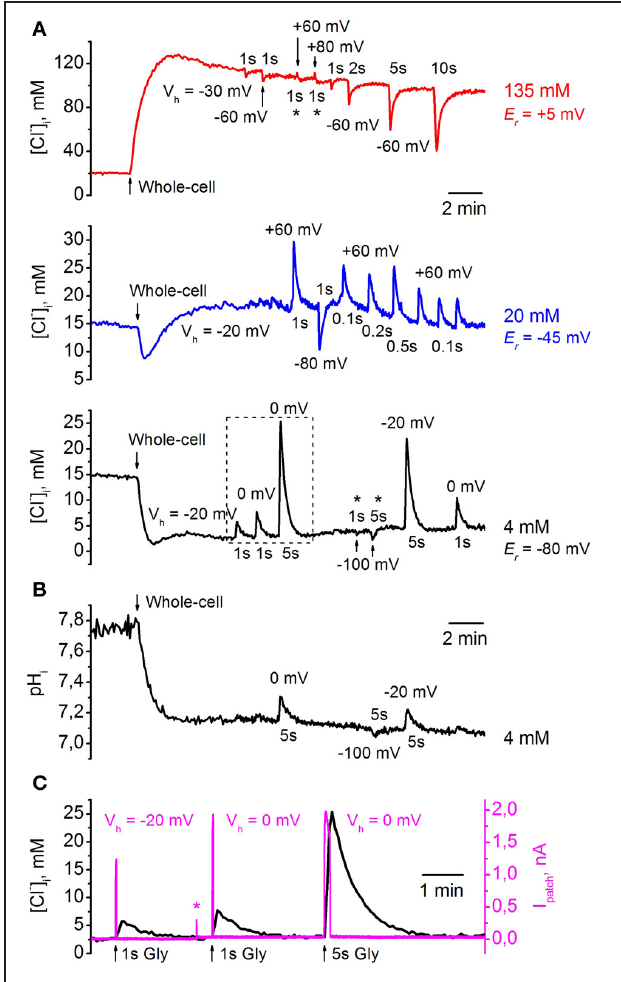
FIGURE 8 | Monitoring of transients of [Cl − ] i and pH i during GlyR activation using ClopHensor. (A) Changes in [Cl − ] i monitored by ClopHensor in three CHO cells co-expressing GlyR and recorded with different [Cl − ] p : 4mM ( black trace ), 20mM ( blue trace ), and 135mM ( red trace ). Transients in [Cl − ] i on transition to whole-cell configuration and GlyR channel activation at different holding potentials ( V h ) and different durations of glycine (200 μ M) pulses are illustrated. Reversal potentials for glycine-induced currents ( E r ) for each cell recorded with different [Cl − ] p are indicated. (B) Changes in pH i monitored simultaneously with [Cl − ] i by ClopHensor in the same cell as in (A) ( black trace ) recorded with [Cl − ] p = 4mM. Note that only the long (5s) glycine application produced noticeable pH i changes of 0.1–0.2 units. (C) Simultaneous monitoring of whole-cell current (I patch ) and [Cl − ] i during glycine application in a cell co-expressing ClopHensor and GlyR and recorded with a [Cl − ] p of 4mM. Responses from dashed frame in (A) ( black trace ) are illustrated. Note: (i) the kinetics of [Cl − ] i transients are much slower than those for corresponding glycine-induced currents (I Gly ); (ii) both amplitudes of I Gly and [Cl − ] i changes increase with elevation of the driving force for Cl − (recordings at V h = − 20 and 0mV); (iii) [Cl − ] i amplitude increases with increasing GlyR channels activation from 1 to 5s, while I Gly amplitudes are similar ( V h = 0mV). Asterisk on I patch trace indicates the artifact when V h changed from − 20 to 0mV. Because of the high input resistance of the cell, the steady-state shift in the current on changing the V h is very weak in comparison with I Gly amplitudes and is not visible on the